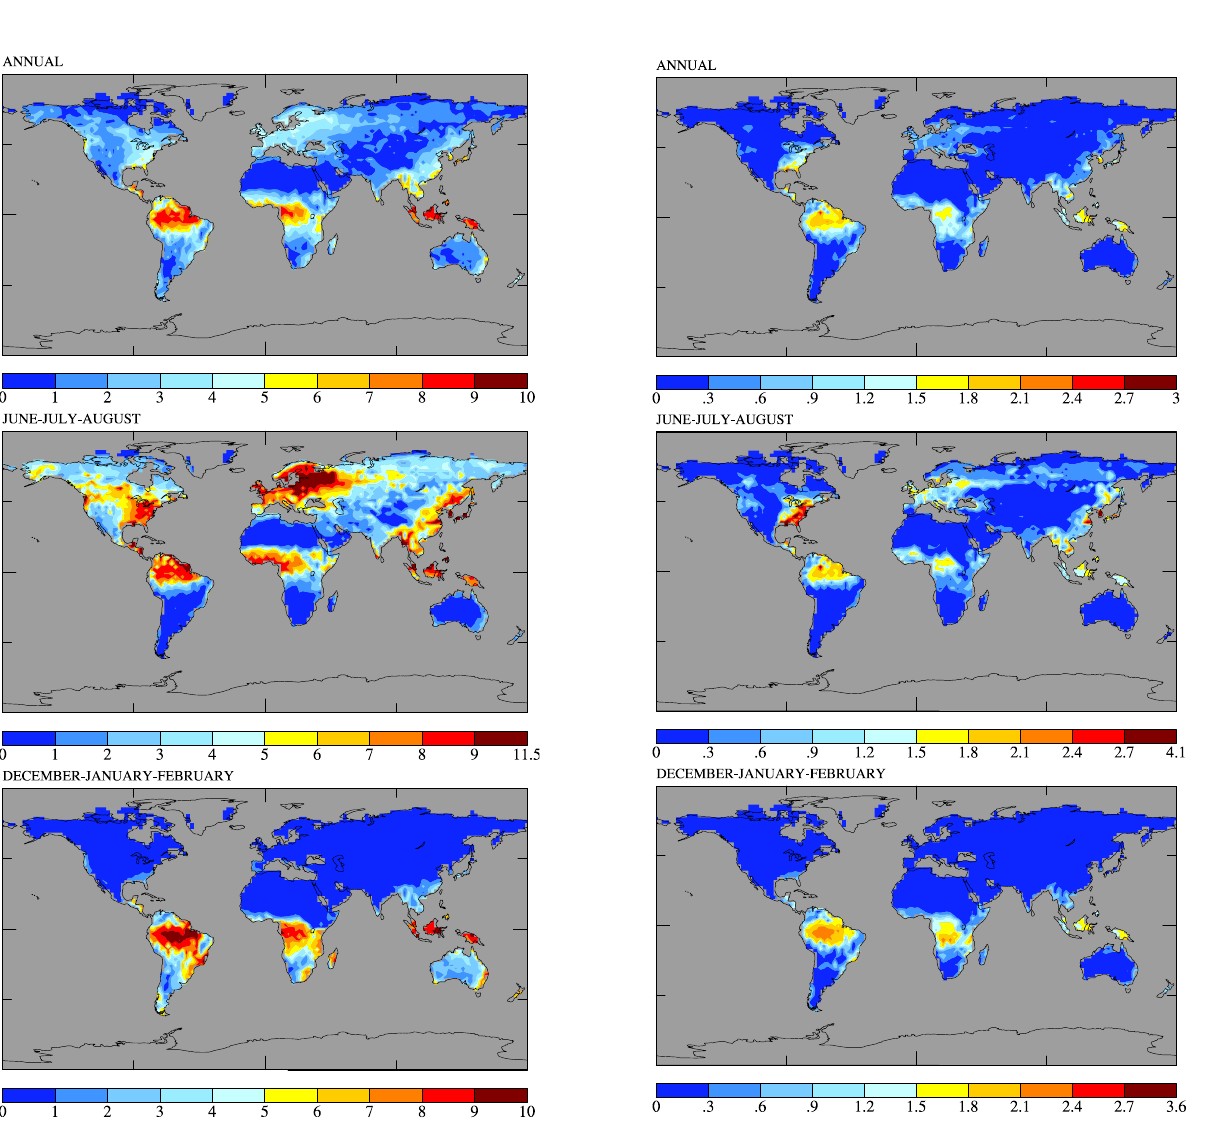
Figure 1(a). Spatial distribution of annual and seasonal average modeled GPP in gC/m 2 /day in the control run SimCONT.